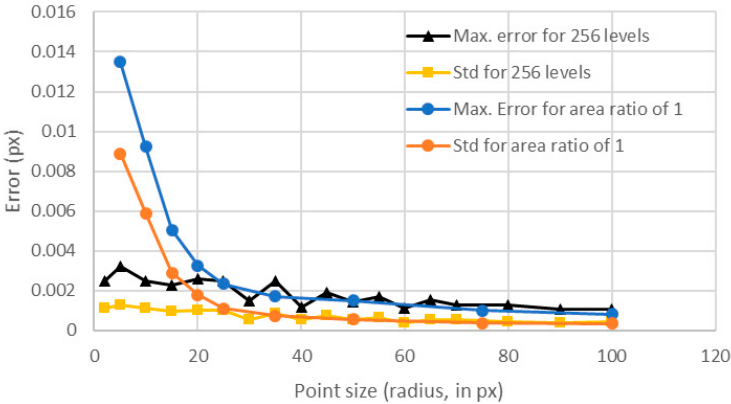
Figure 12. Comparison between the errors obtained for an area ratio of 1 and for 256 levels (superposition of Figures 7 and 11).